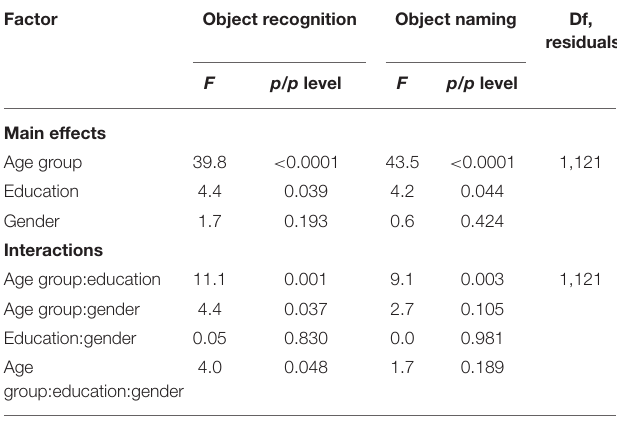
TABLE 8 | Influence of subject-specific factors on object recognition and naming.